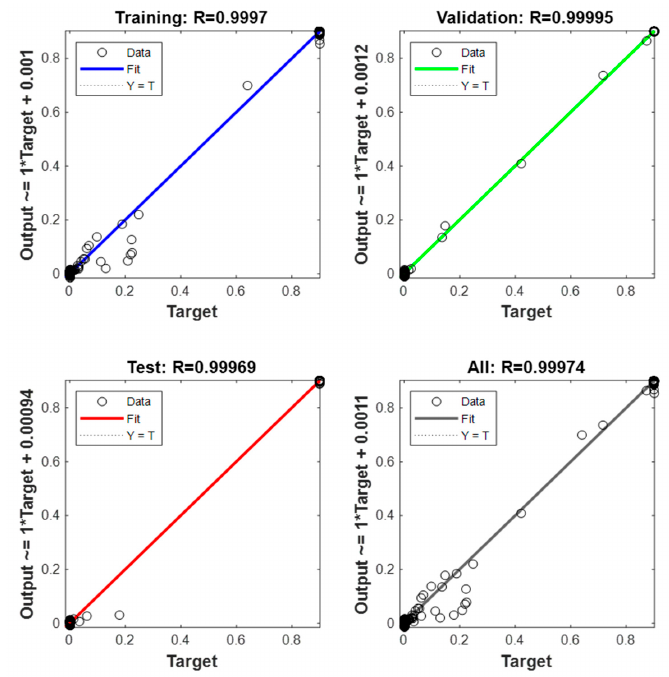
Figure 11. Regression of the optimal NARX network.